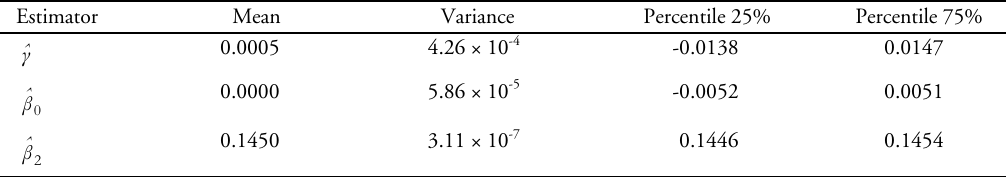
Monte Carlo indices of MLEs of structural parameters based on 10 4 samples.